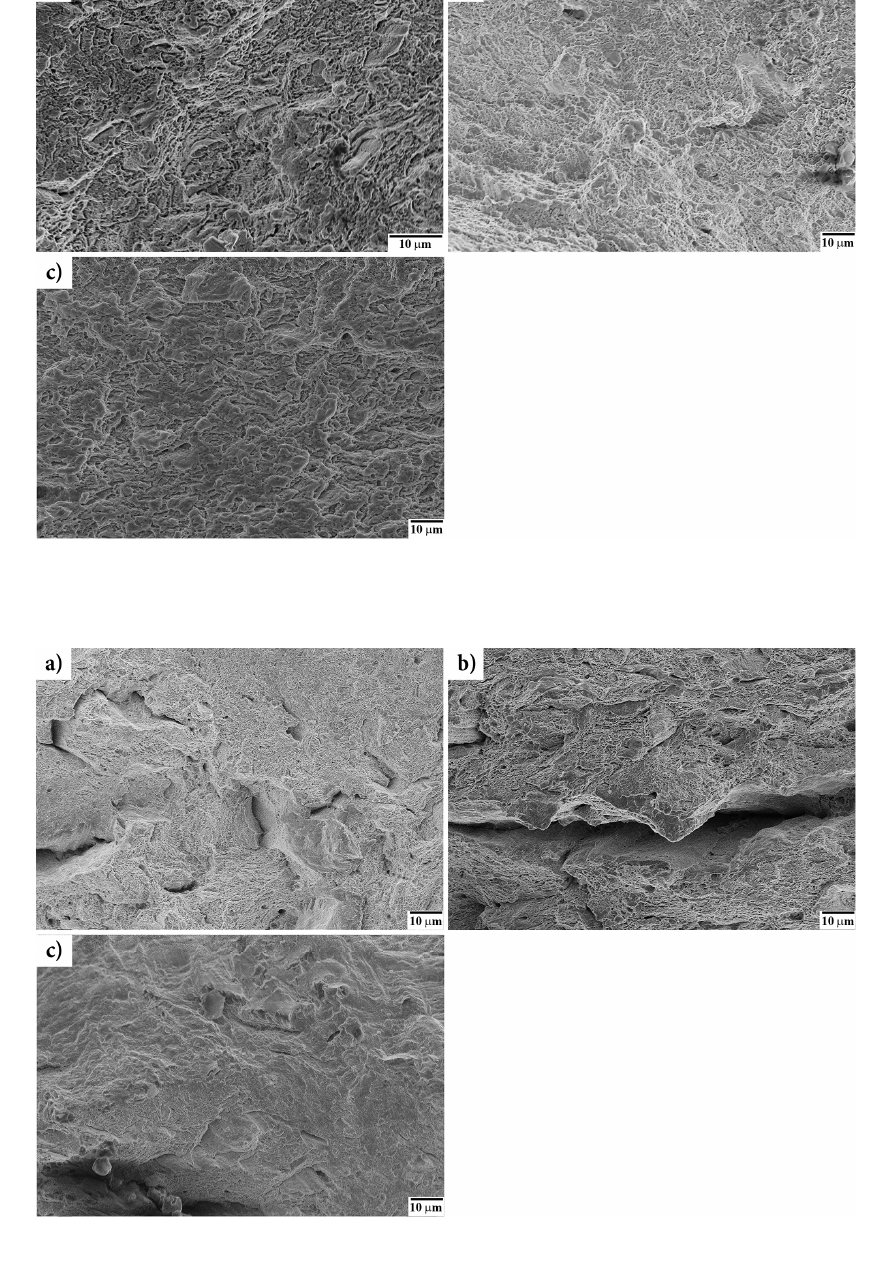
4. Solutionizing temperature has an inverse relation- ship with ultimate tensile strength. However, even